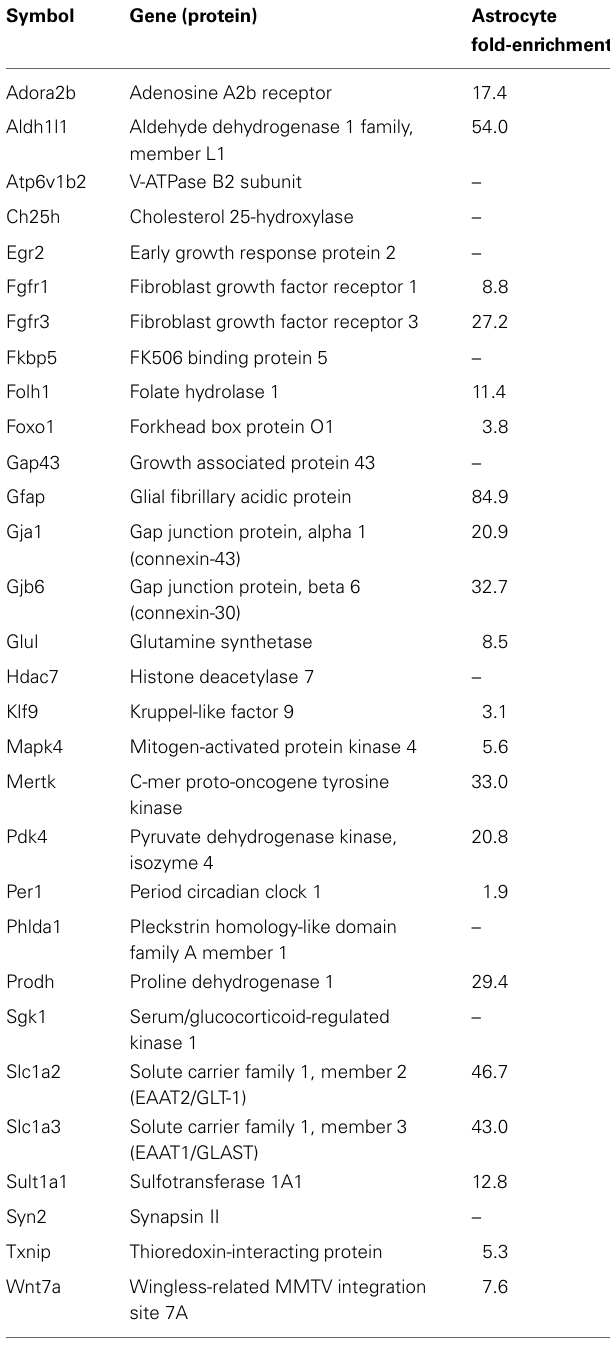
Table 1 | mRNAs assessed for glucocorticoid regulation in the brain in